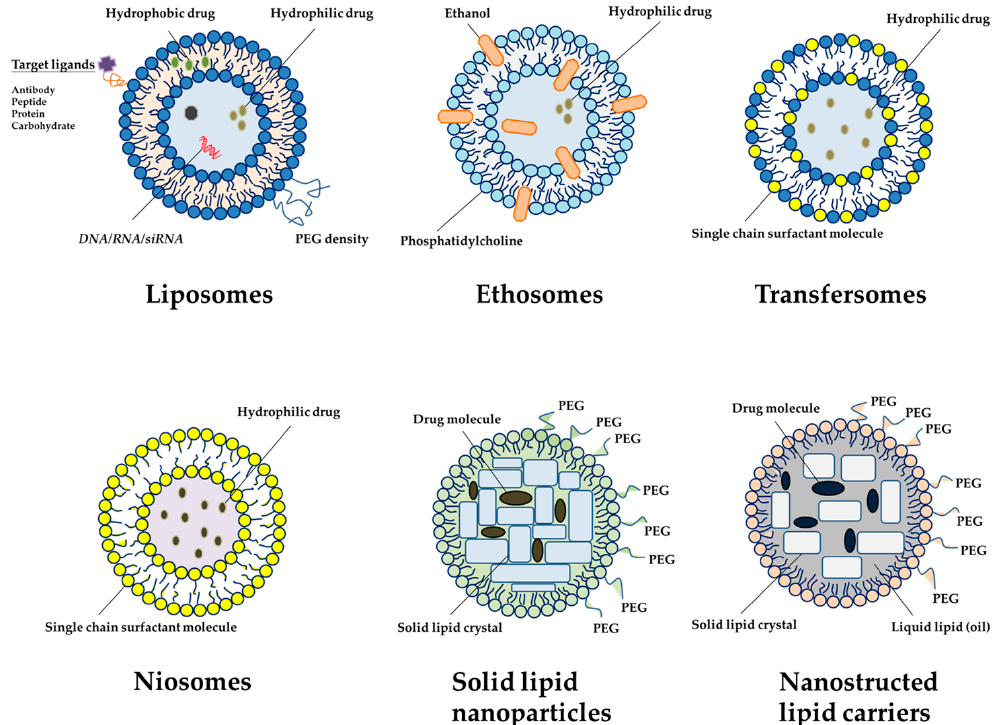
Figure 2. An overview of different types of lipid nanocarrier systems used for the treatment of arthritic diseases (plotted in Table 3). In brief, liposomes are typically composed of natural phospholipids, a major component of most biological membranes. Ethosomes are lipid vesicles composed of phospholipids and a large amount of ethanol. Transfersomes are liposomes with deformable properties enabling the stratum corneum to pass and penetrate deeply into the skin. Solid lipid nanoparticles are constituted by a mixture of solid lipids dispersed in inner cores. Nanostructured lipid carriers are formed by the mixture of solid lipids and liquid lipids in the cores. PEG: Polyethylene glycol.